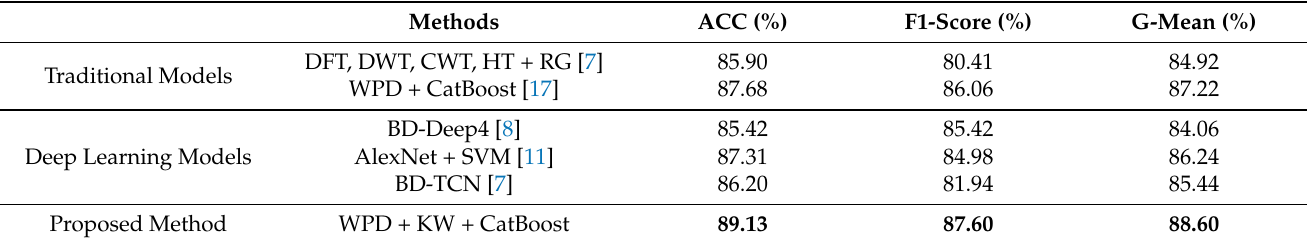
Table 3. Comparison of results with different methods using the same public EEG dataset.